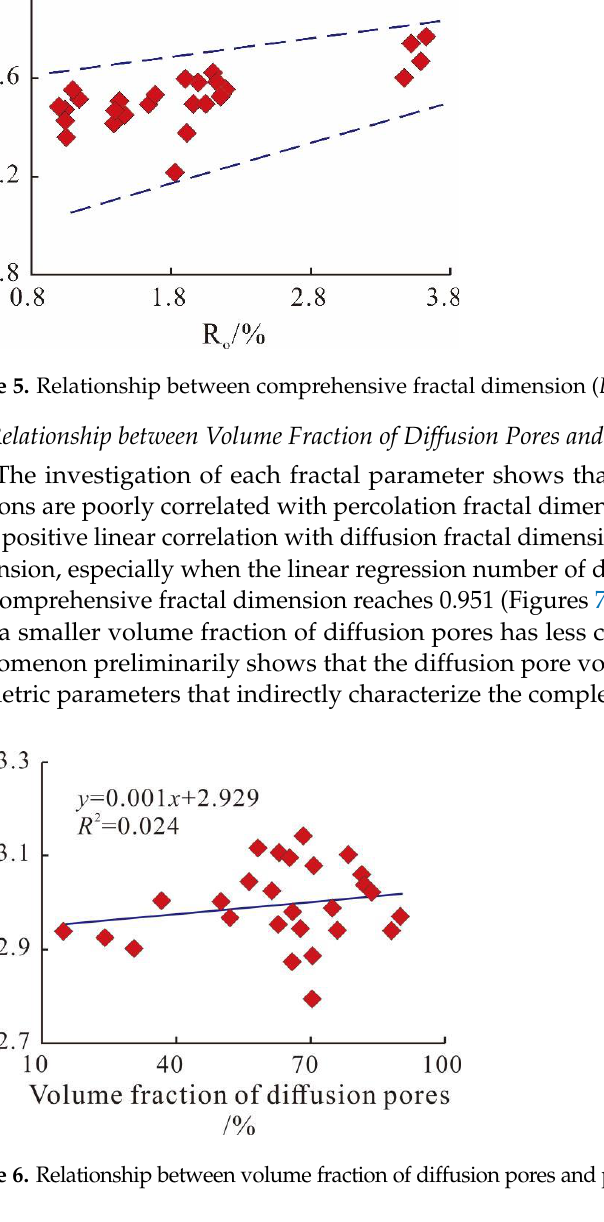
Figure 4. Relationship between diffusion fractal dimension ( D d ) and vitrinite reflectance (R o ).